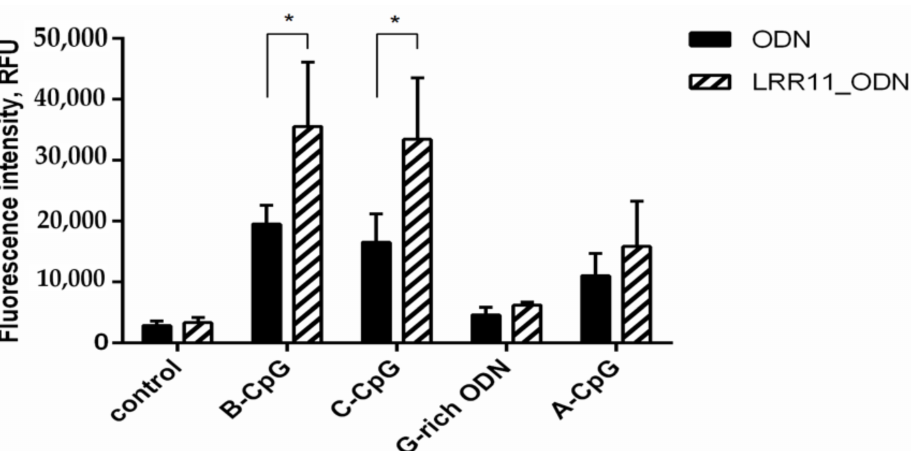
Figure 8. When added simultaneously, LRR11 potentiates the prooxidant effects of oligonucleotides. H 2 DCF-DA-stained PMNLs (1 × 10 6 /mL) were cultured for 1h at 37 ◦ C in 5% CO 2 without additives or in the presence of 1 µ M ODN, supplemented (shaded) or not (solid fill) with 1 µ M LRR11. DCF green fluorescence signals (ex. 485 nm, em. 538 nm) were monitored every 5 min for an hour. Values represent the means ± SEM of DCF fluorescence intensity increments (RFU) in 30 min after stimulus addition ( n = 3). * p < 0.05 for the pairs of data specified, as indicated by two-way ANOVA followed by Tukey’s multiple comparison